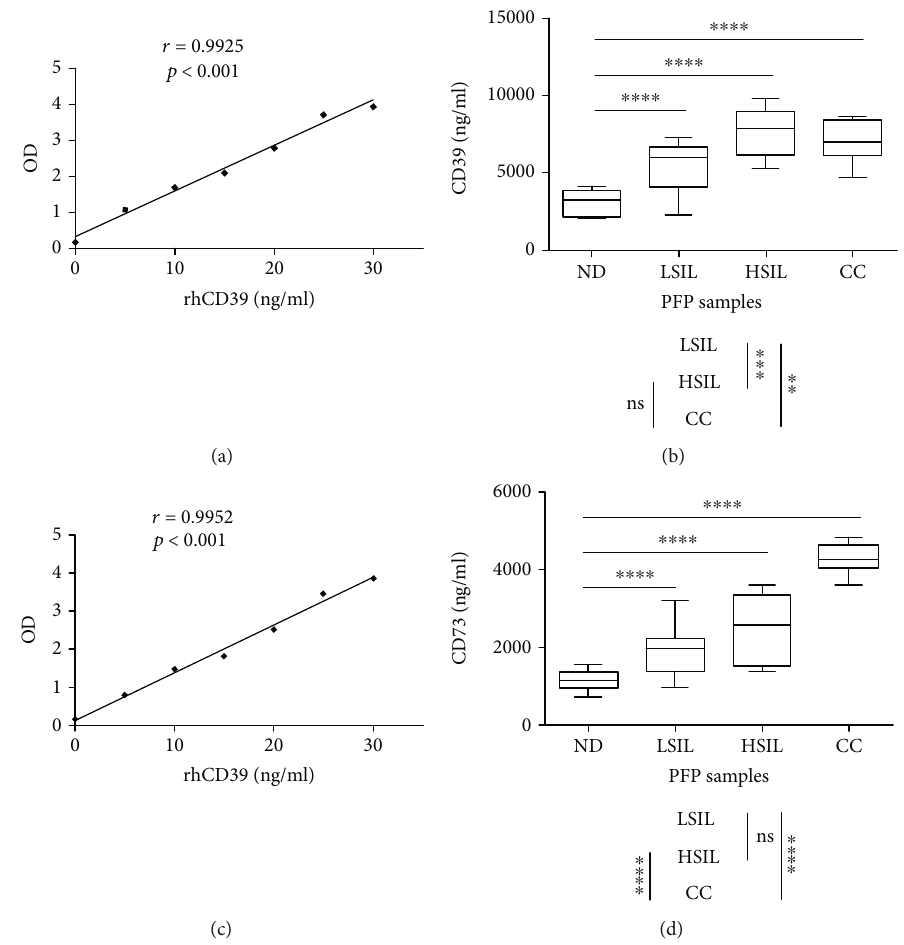
Figure 1: CD39 and CD73 concentrations in PFP samples from NDs and patients with LSILs, HSILs, or CC. The type curves for soluble CD39 and CD73 were established by ELISA using di ff erent concentrations (5-30ng/ml) of human recombinant proteins CD39 (rhCD39) (a) and CD73 (rhCD73) (c), whose correlations with absorbance (optical density) were r = 0 : 9925 ( p < 0 : 001 ) and r = 0 : 9952 ( p < 0 : 001 ), respectively. For the detection of CD39 and CD73, the PFP samples of the NDs and women with LSILs, HSILs, or CC were diluted with PBS at ratios of 1:40,000 and 1: 25,000, respectively. The data are representative of three independent experiments. The means ± SEMs of the concentrations of soluble CD39 (b) and CD73 (d) detected in the PFP of the NDs and patients with LSILs, HSILs, or CC are shown. Signi fi cant di ff erences are indicated by ∗ ( p < 0 : 05 ), ∗∗ ( p < 0 : 001 ), and ∗∗∗ ( p < 0 : 0001 ). ns: not signi fi